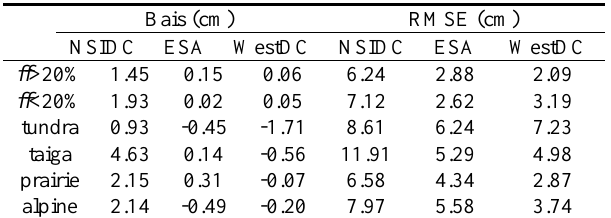
Figure 4. The snow depth are compared to in situ observation from 2002 to 2011